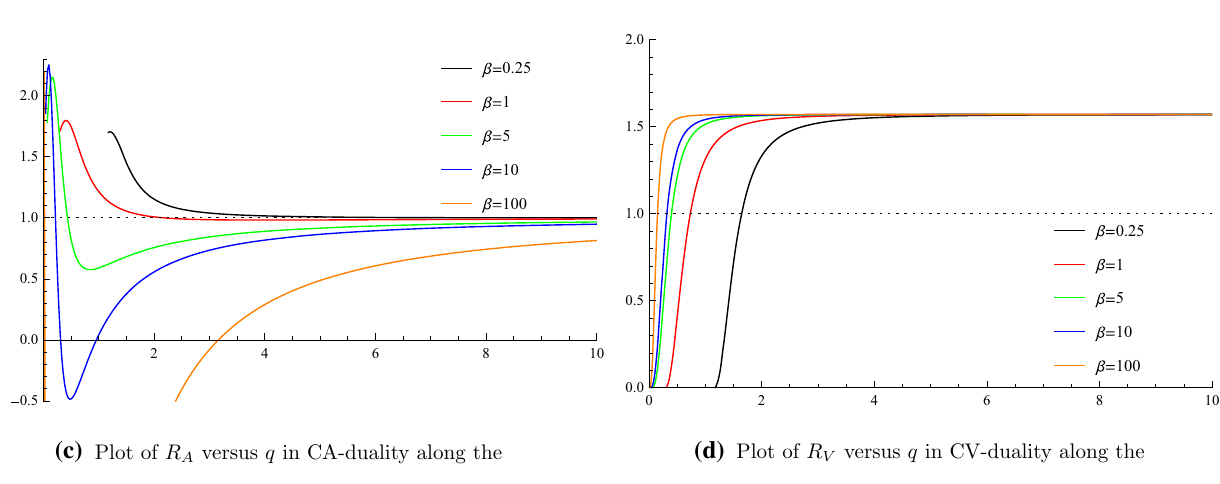
(b) Plot of R V versus q in CV-duality along the ( a ) Plot of R A versus q in CA-duality along the Φ = 1.5 curve starting from the extremal boundary. Φ = 1.5 curve starting from the extremal boundary.